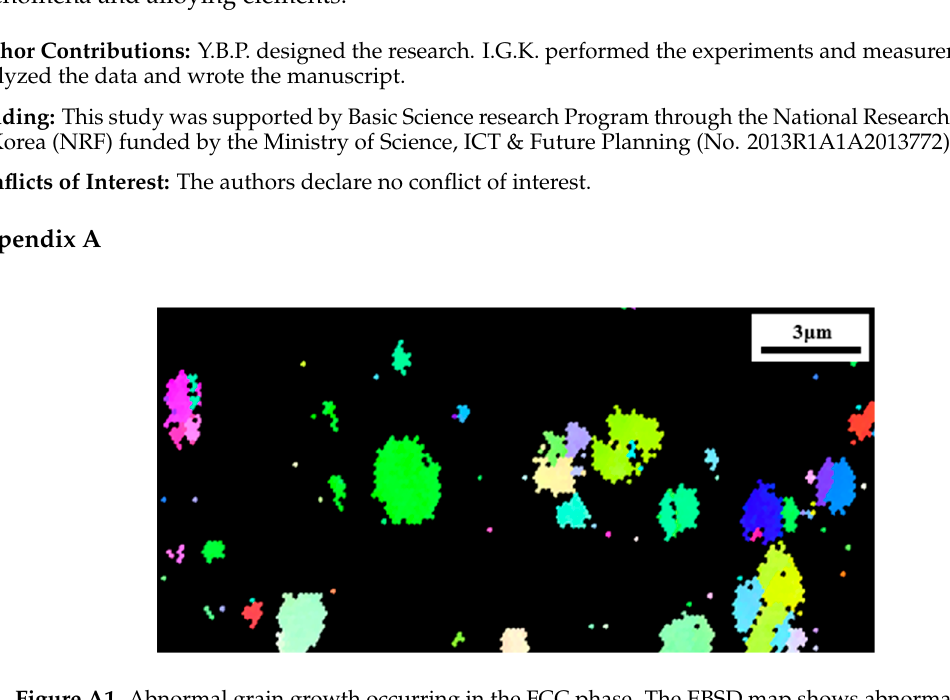
Figure A2. Lattice parameters of the α , γ′ and γ″ phases. The XRD data were collected for the same samples used for Figure 1.